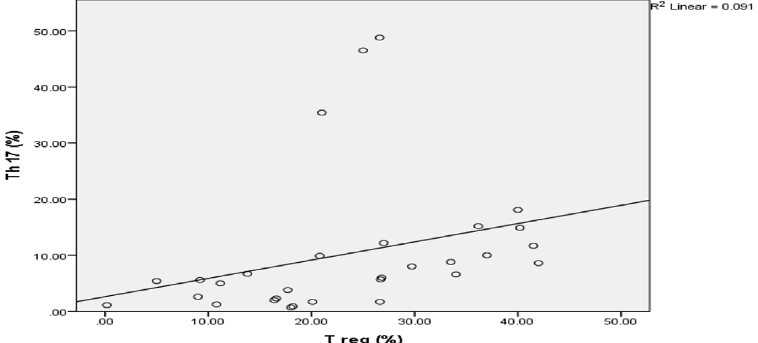
Fig. 4. Correlation between T-regs and Th-17 cells frequencies among CHC patients before